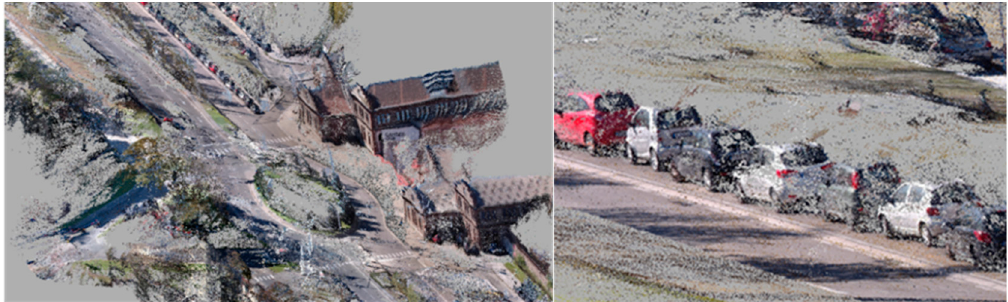
Figure 5. The resulting geo-referenced dense point cloud of the road infrastructure (on the right) and the detail of the parked cars.